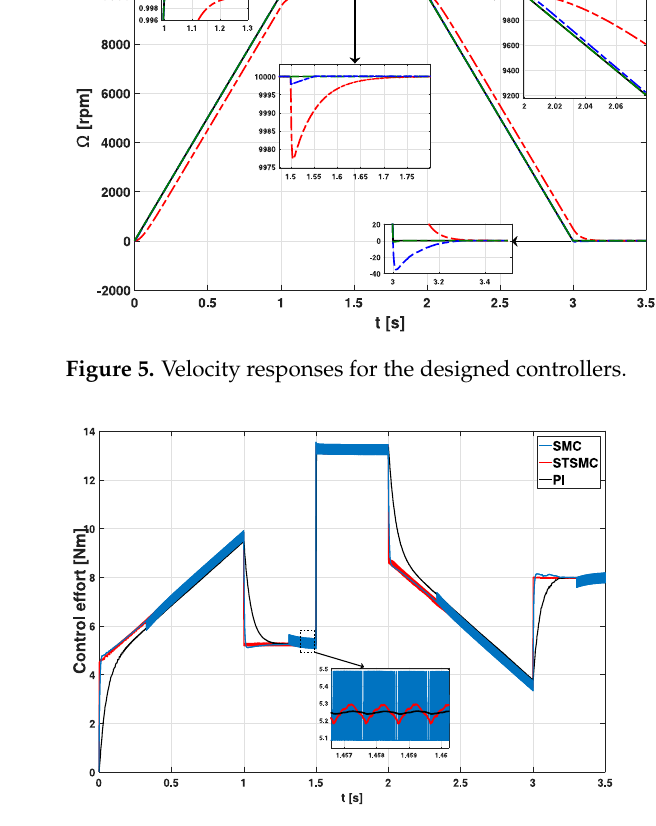
Figure 6. Torque responses for the designed controllers.